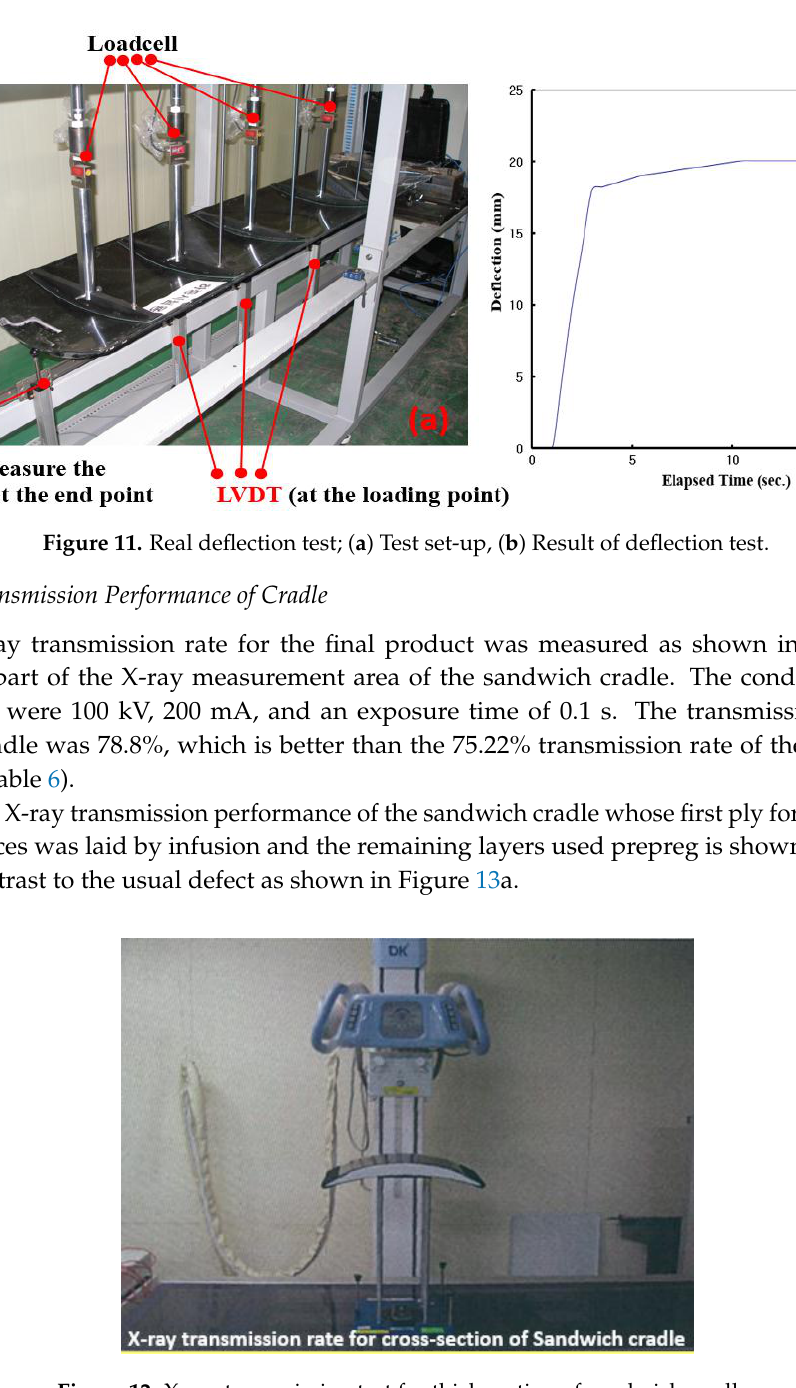
Figure 12. X-ray transmission test for thick section of sandwich cradle. Table 6. X-ray Transmission rate of Final sandwich